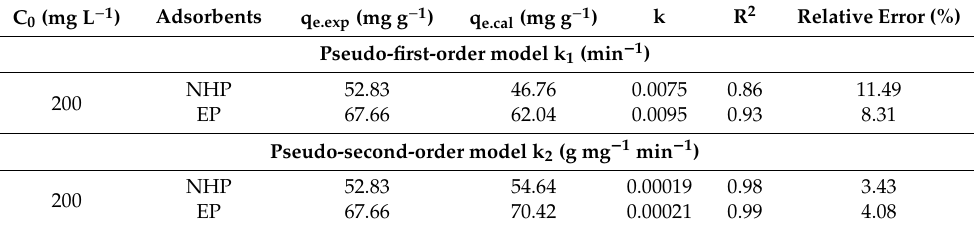
Figure 3. Adsorption kinetics of EGCG onto processed pomelo peel ( a ), and the experimental data fitted to pseudo-first-order ( b ) and pseudo-second-order models ( c ), respectively, at 25 ◦ C. Initial [EGCG] = 200 mg L − 1 . Table 1. Kinetic parameters of EGCG adsorption onto processed pomelo peel